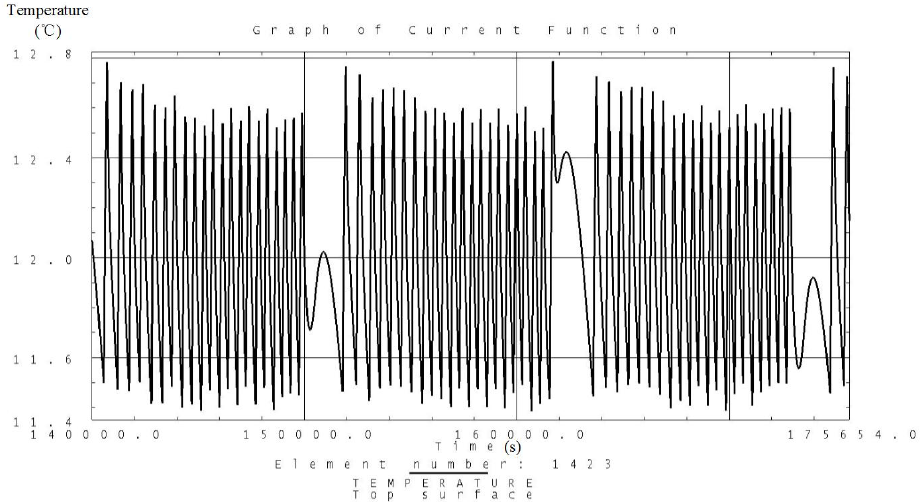
Sensors 2019 , 19 FOR PEER REVIEW